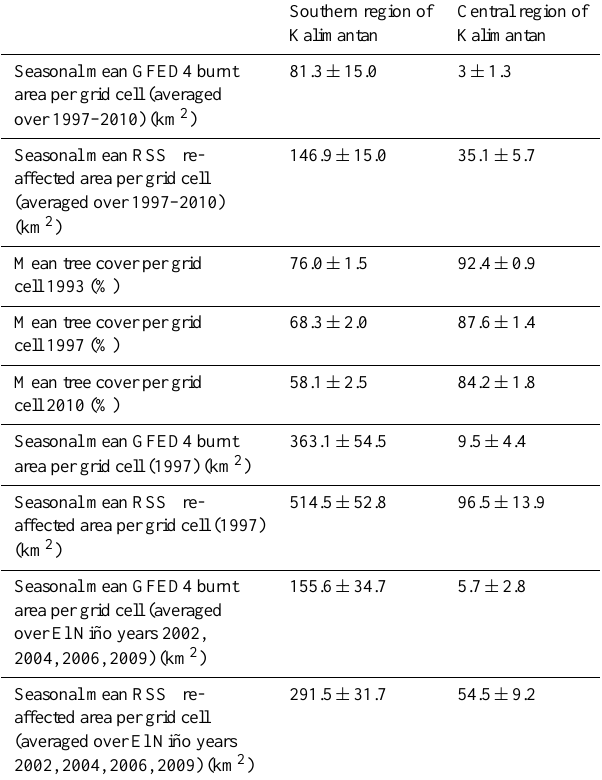
Table 1. Summary statistics for burnt and fire-affected area and tree cover in the southern and central regions of Kalimantan. Val- ues shown are mean ± 1.96 × SE mean . Number of grid cells in the southern region is 53. Number of grid cells in the central region is 40. Grid cell resolution is 0.5 ◦